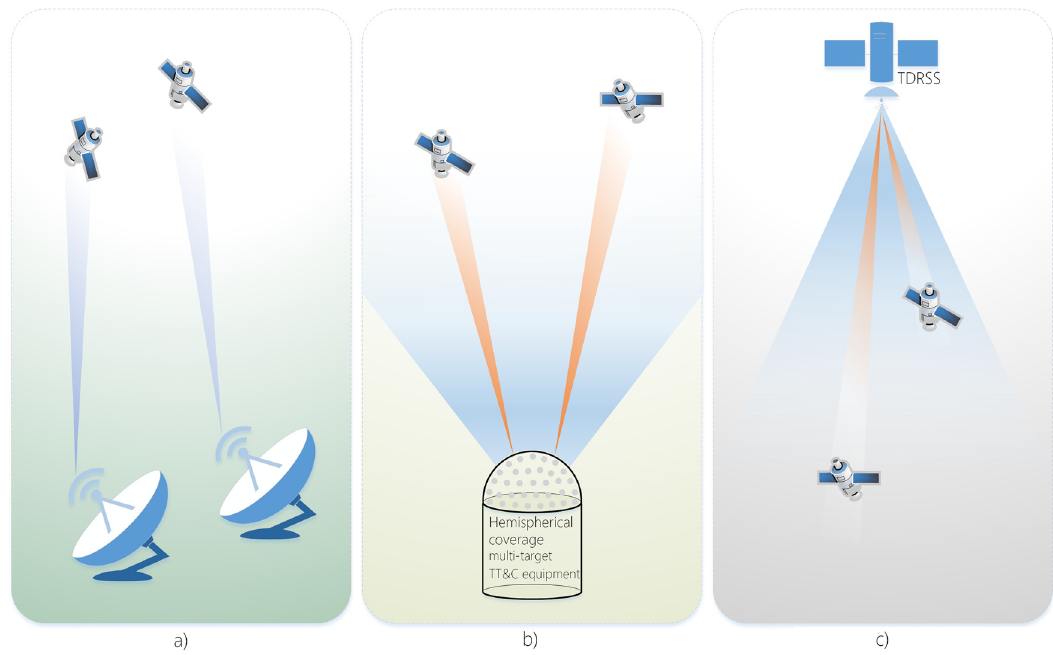
Figure 3: Schematic diagram of three TT&C equipment under two access modes: ( a ) traditional access mode, ( b ) ground - based AOE mode, and ( c ) space - based AOE